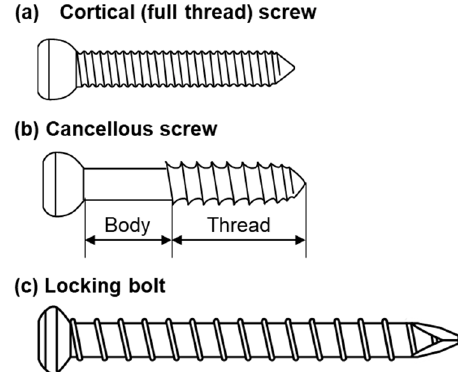
Figure 1. Shapes of typical screws used in this study.